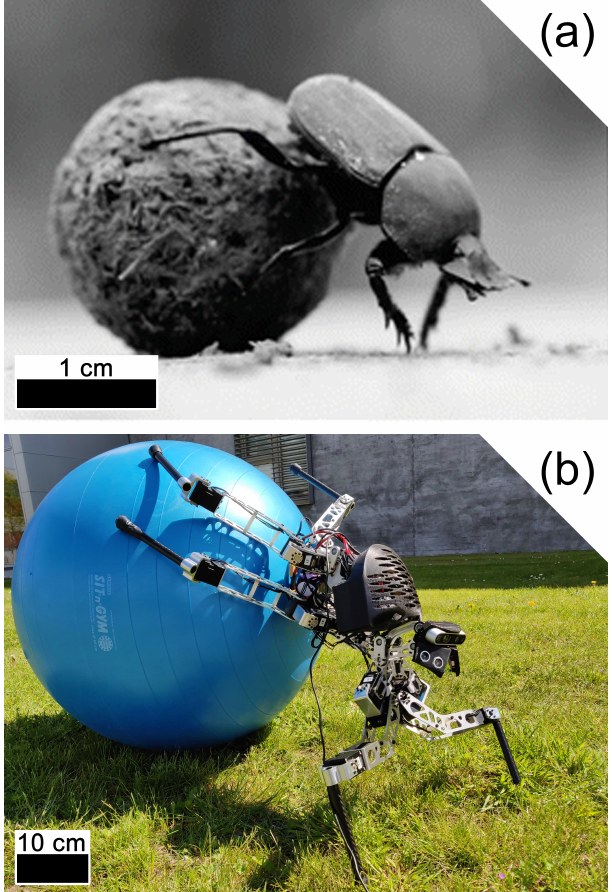
Figure 2. The African ball-rolling dung beetle (photo: Emily Baird) ( a ), and the dung beetle inspired robot ALPHA ( b